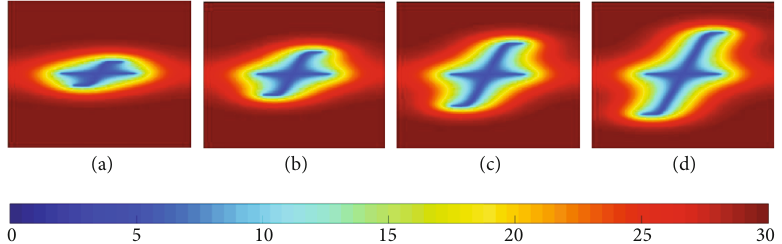
= 20m , (b) L = 50m , (c) L = 80 m , f 2 r f 2 r f 2 r